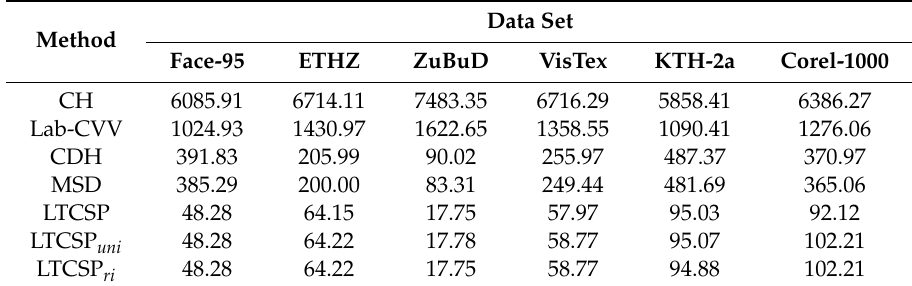
Table 3. The mean square errors obtained by the hierarchical quantization schemes of di ff erent descriptors on six